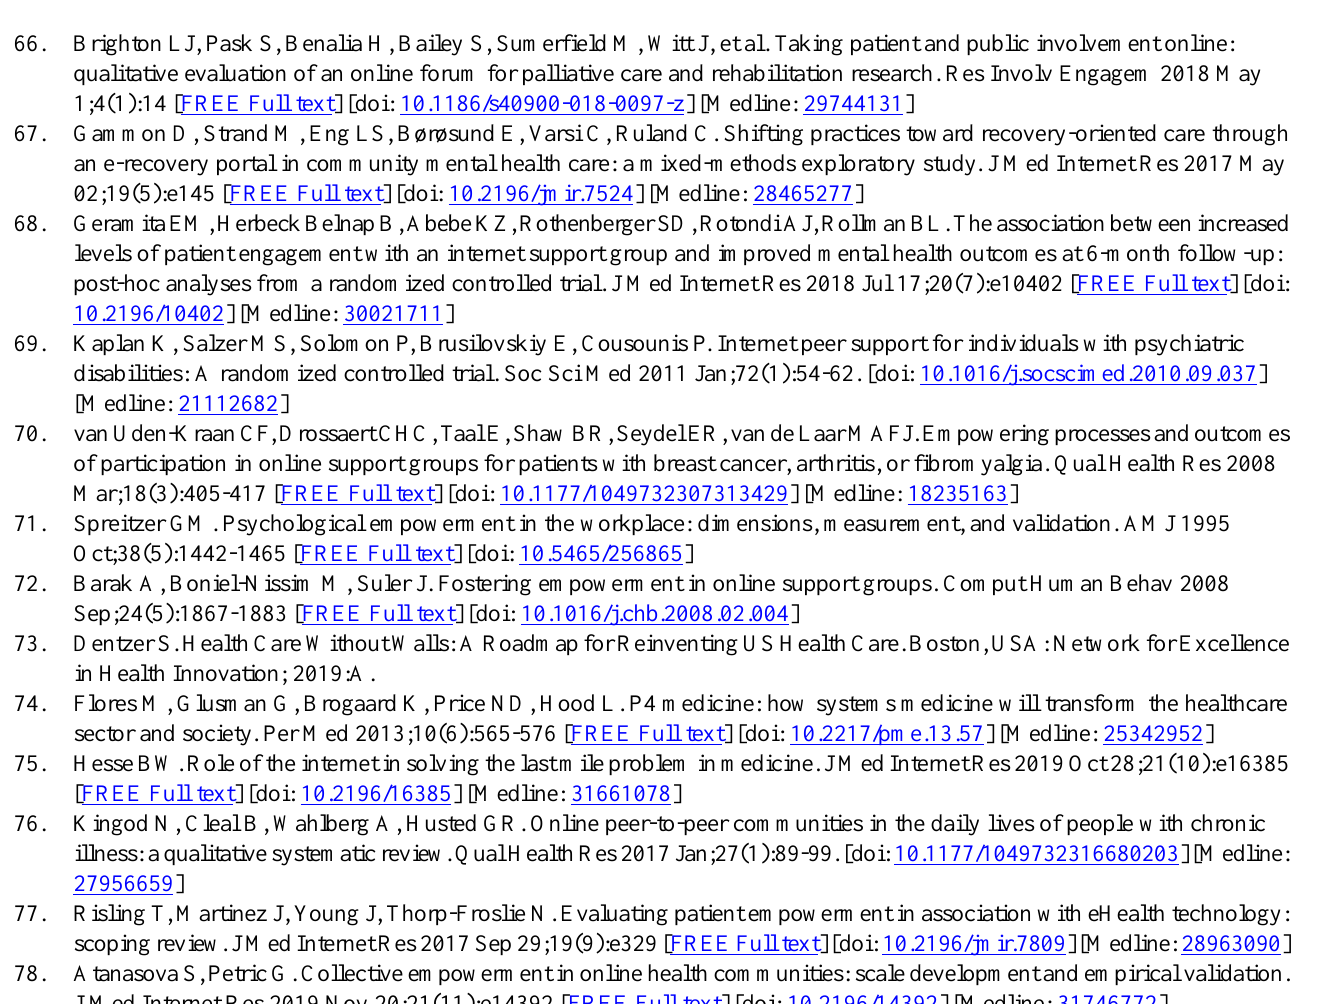
PRISMA: Preferred Reporting Items for Systematic Reviews and